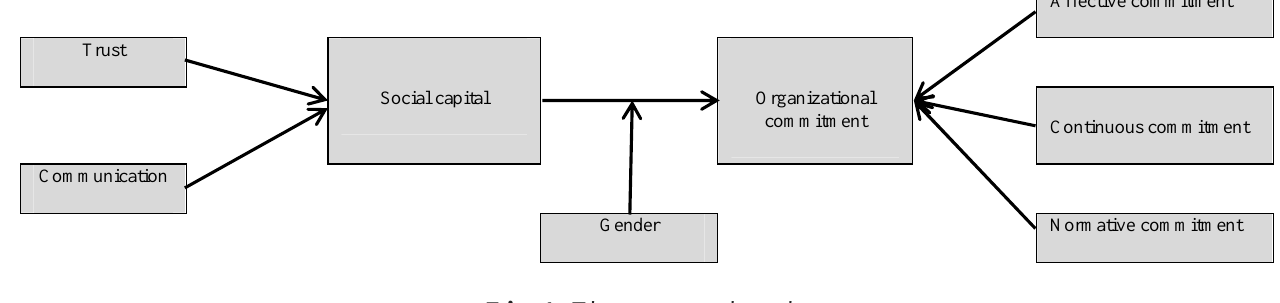
Fig. 1. The proposed